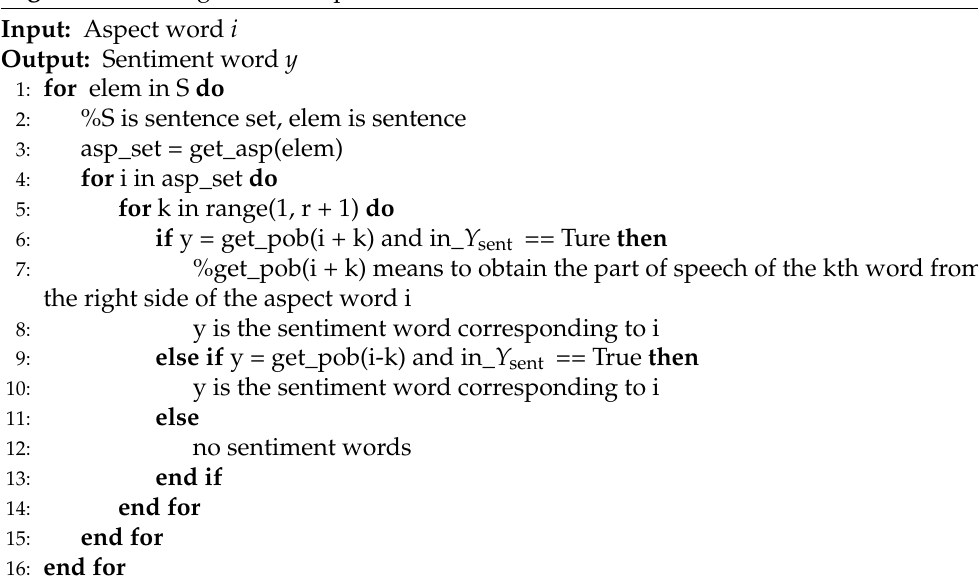
Algorithm 1 Recognition of aspect